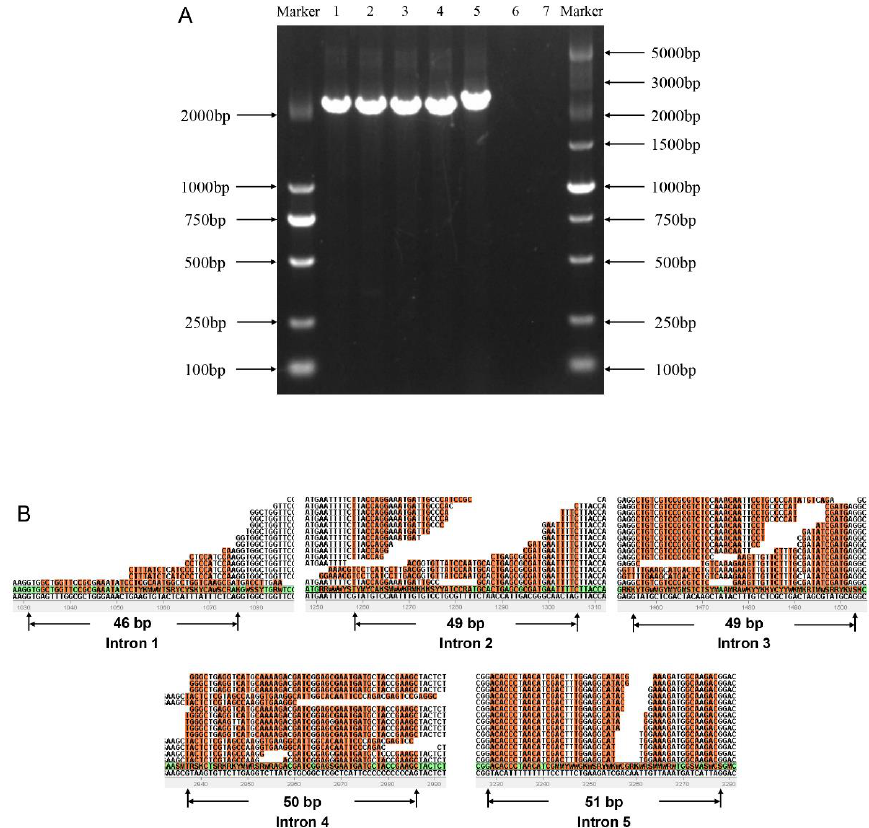
Figure 2. Validation of the full-length ORF and unitary transcript of FfSpdsSr gene in F. filiformis . ( A ) Full-length ORF amplification results of FfSpdsSr gene in F. filiformis . Numbers 1–4 represent the full-length ORF of chimeric FfSpdsSr amplified from cDNA of monokaryon L11 (isolated from dikaryon FL19), L22 (isolated from dikaryon FL19), 6-3 (isolated from dikaryon NJ6), and 6-21 (isolated from dikaryon NJ6) in F filiformis , respectively. Number 5 represents the full length of gDNA of FfSpdsSr in F. filiformis strain L11. Numbers 6–7 represent the PCR results using cDNA as template and the combined primers (the beginning of ORF of NcSpds as forward primer and the end of ORF of NcSr as reverse primer) in N. crassa strain, FGSC#4200 and FGSC#2489. The markers 2000 and 5000 are shown on the side of the electropherogram. ( B ) Alternative splicing analysis of FfSpdsSr in F. filiformis . The orange parts represent the intron region of FfSpdsSr .